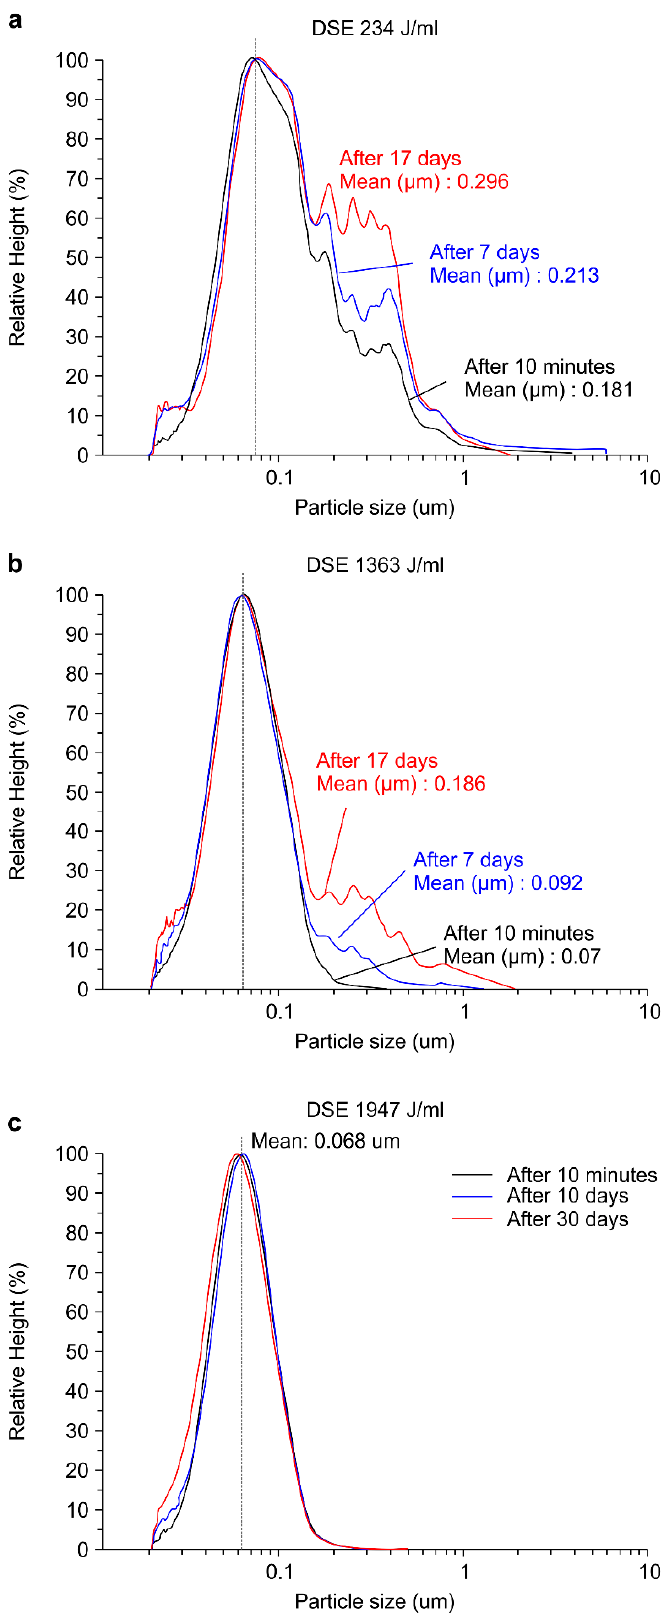
Figure 10. Particle size, size distributions, and stability of TiO 2 colloids with DSE values of ( a ) 234, ( b ) 1363, and ( c ) 1947 J/mL.